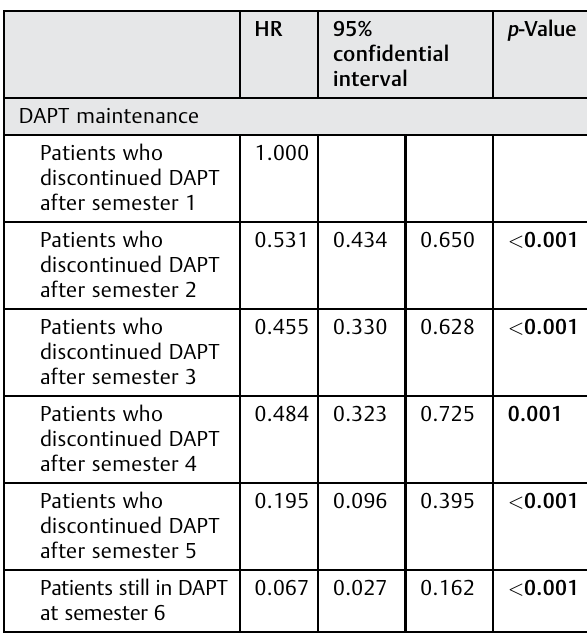
Abbreviations: AAII, angiotensin II receptor antagonist; ACE, angioten- sin-converting enzyme; DAPT, dual-antiplatelet therapy; HR, hazard ratio; MI, myocardial infarction; N.S., not signi fi cant; PCI, percutaneous coronary intervention. Notes: N ¼ 5,027, no. of events ¼ 580.